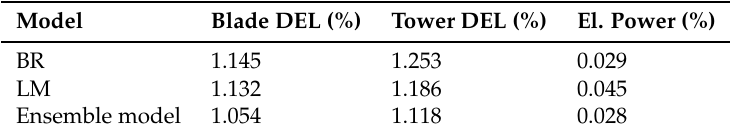
Table 2. Normalised RMSE of the surrogate models.